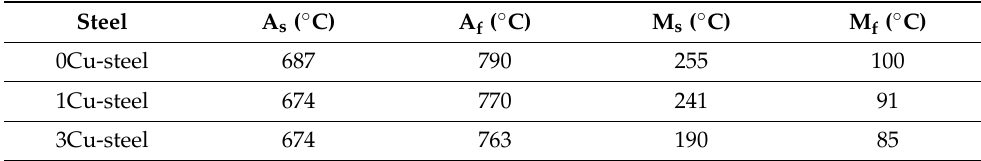
Table 2. The phase transition points of the three steels. Figure 1. Thermal expansion curves of the three steels with different Cu content: ( a ) 0Cu, ( b ) 1wt.% Cu, and ( c ) 3wt.% Cu.